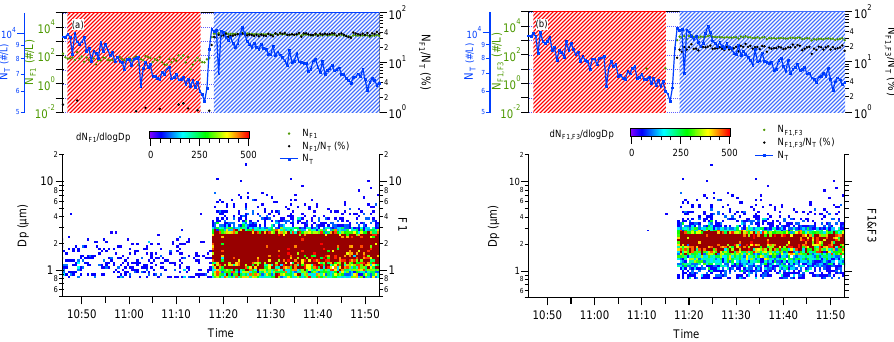
Fig. 3. WIBS-4 fluorescence data for ammonium sulphate aerosol and penicillium notatum spores measured during the BIO-05 campaign (24 March 2010 at IMK-AAF, KIT). Upper panel, left axis: number concentrations of all detected particles and fluorescent biological aerosol particles in the size range 0.8–16µm, blue and green markers, respectively. Upper panel, right axis: ratio of the number of fluorescent particles to the total number concentration, black markers. Lower panel: Size distribution (d N /dlog D p ) of fluorescent particles for the entire experiment period. The experimental period of pure ammonium sulphate aerosol is highlighted by a red shaded area, while the mixture of ammonium sulphate and fungal spores is represented by a blue shaded area. Panel (a) shows the results using only events in channel F1 for discriminating biological particles, while (b) uses the combination of simultaneous events in channels F1 and F3.